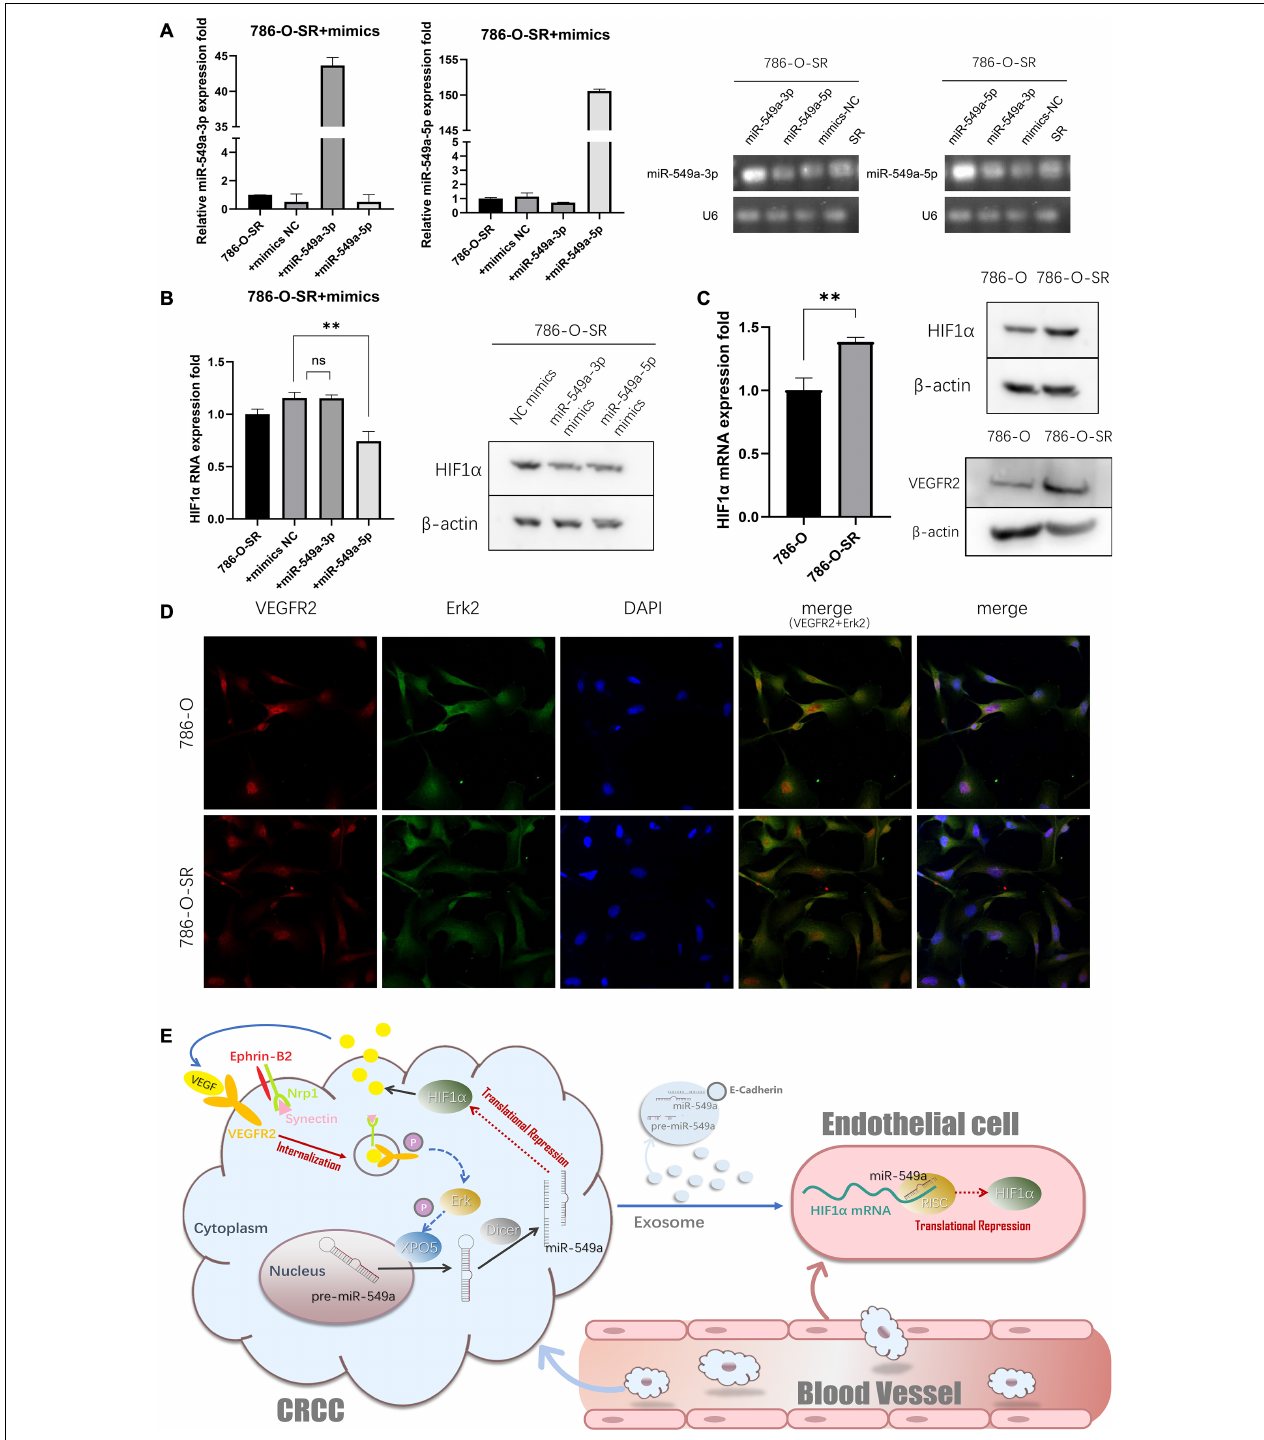
FIGURE 8 | miR-549a achieved positive feedback regulation of VEGF-VEGFR2-Erk2 pathway in tumor cells via HIF1 α . (A) RT-PCR and western blotting analysis of HIF1 α expression in 786-O and 786-O-SR. VEGFR2 expression in 786-O and 786-O-SR by western blot. ∗∗ P < 0.01; ns, not significant according to two-tailed Student’s t -test. (B) RT-PCR and western blotting analysis of HIF1 α expression in 786-O-SR, 786-O-SR + mimics NC, 786-O-SR + miR-549a-3p mimics and 786-O-SR + miR-549a-5p mimics. (C) The detection of transfection efficiency of miR-549a-3p/miR-549a-5p mimics in 786-O-SR by RT-PCR and gel electrophoresis of PCR products analysis. (D) The subcellular localization of VEGFR2 and Erk2 was examined by confocal microscopy analysis. (E) Schematic diagram of the role of exosomal miR-549a in tumor metastasis and TKI resistance.